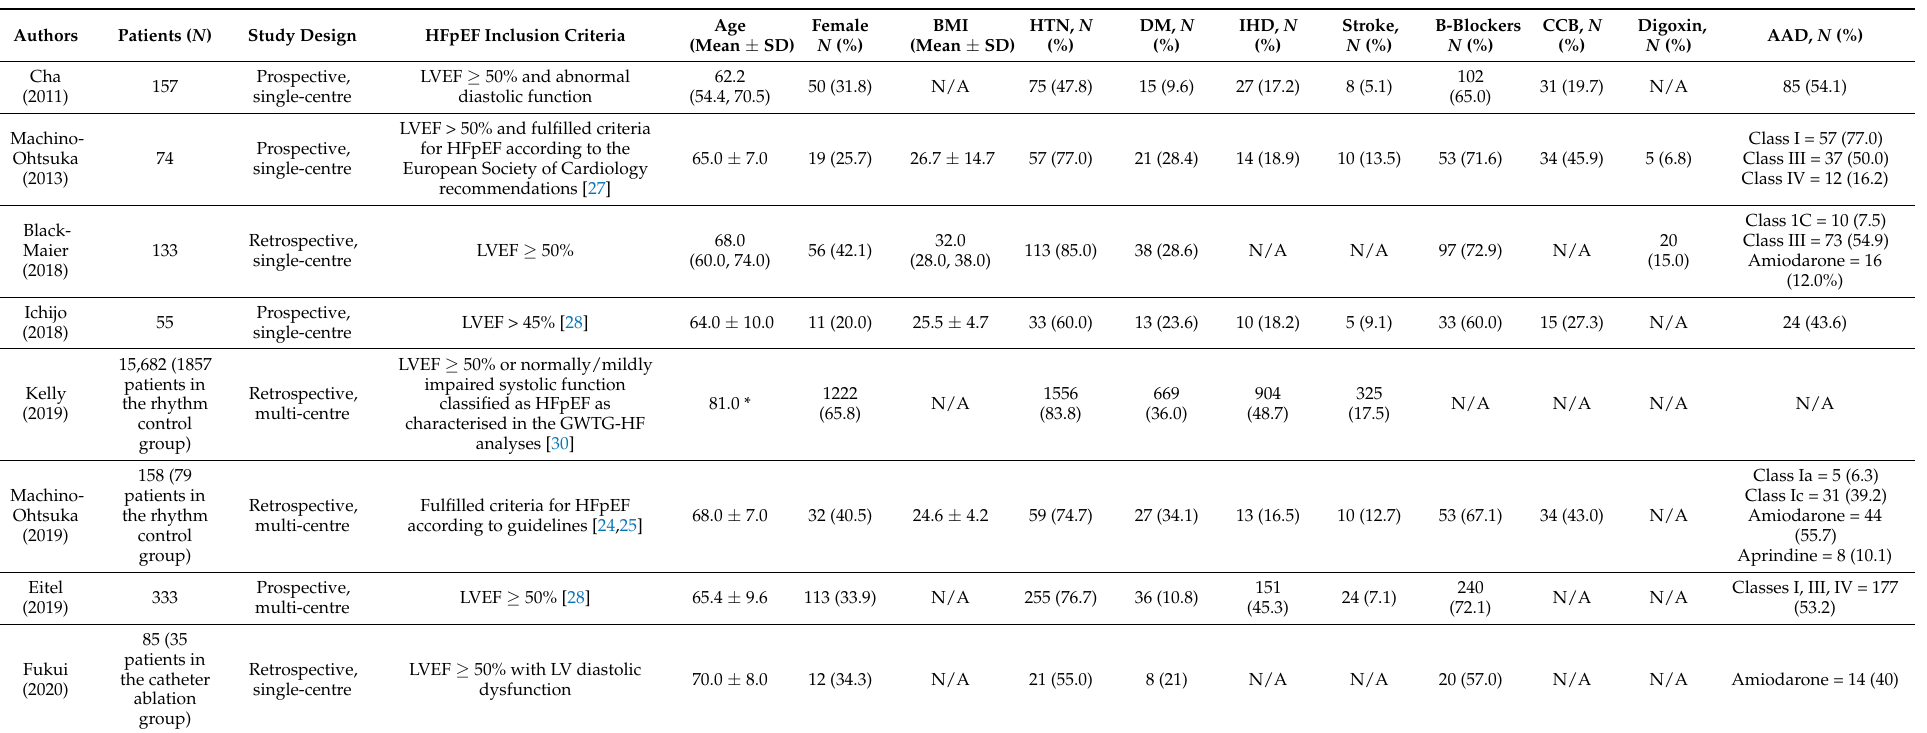
Table 1. Baseline characteristics of selected